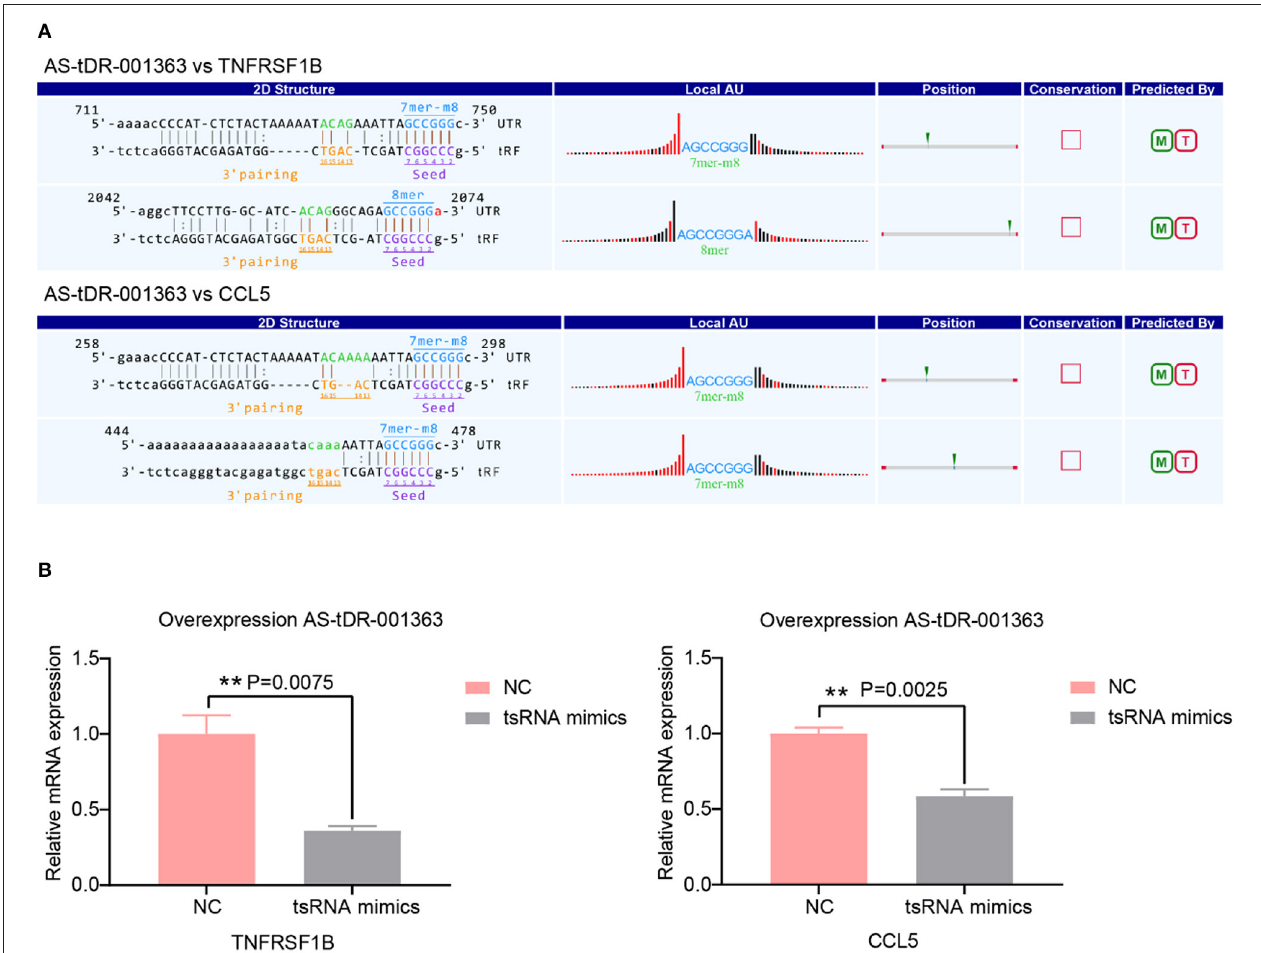
FIGURE 4 | Target genes validation. (A) The binding region and seed sequence of AS-tDR-001363 randomly selected mRNA transcripts (TNFRSF1B and CCL5). (B) The relative mRNAs levels detected by qRT-PCR in AC16 cells transfected with tsRNAs mimics. The qRT-PCR results of TNFRSF1B and CCL5 level in AC16 cells transfected with AS-tDR-001363. The data are exhibited as the mean ± SEM ( n = 3). ** P < 0.01 presented tsRNAs mimics compared to the NC